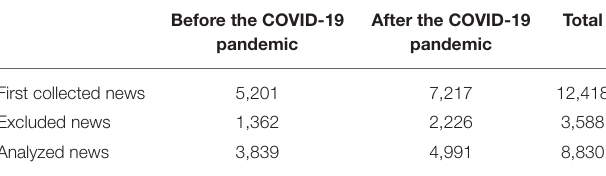
TABLE 2 | The number of analyzed news texts (number of